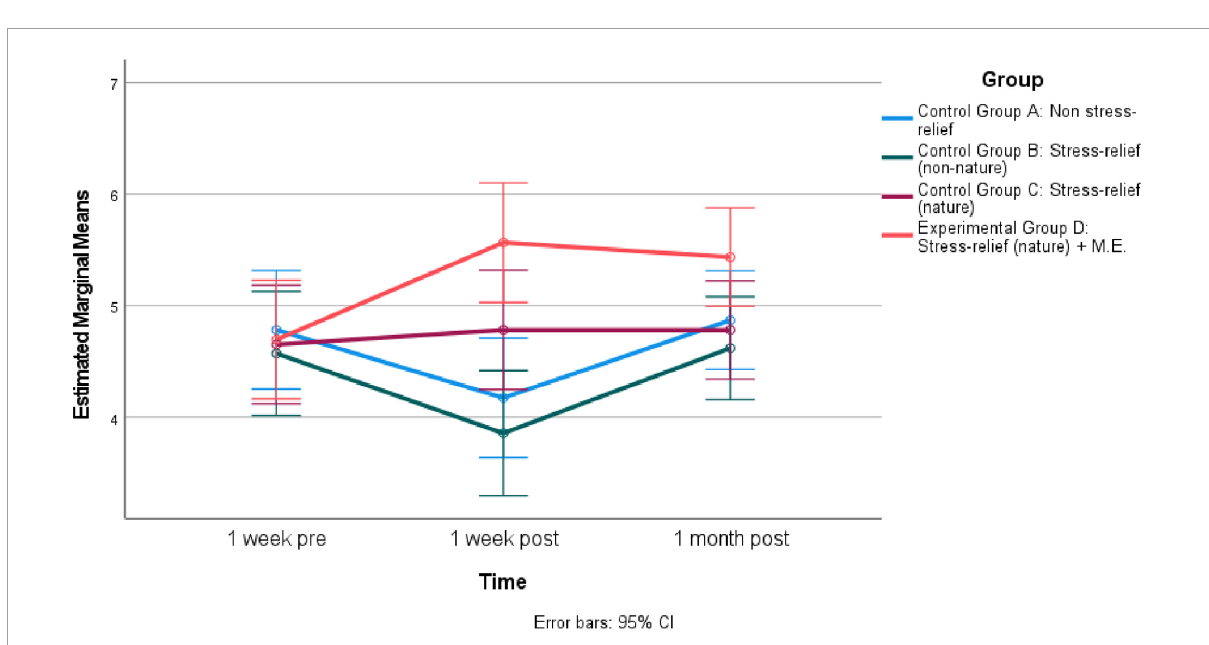
FIGURE3 Estimated marginal means of “Intend to expose oneself to nature for stress-relief” across different time for four groups ( N = 90).